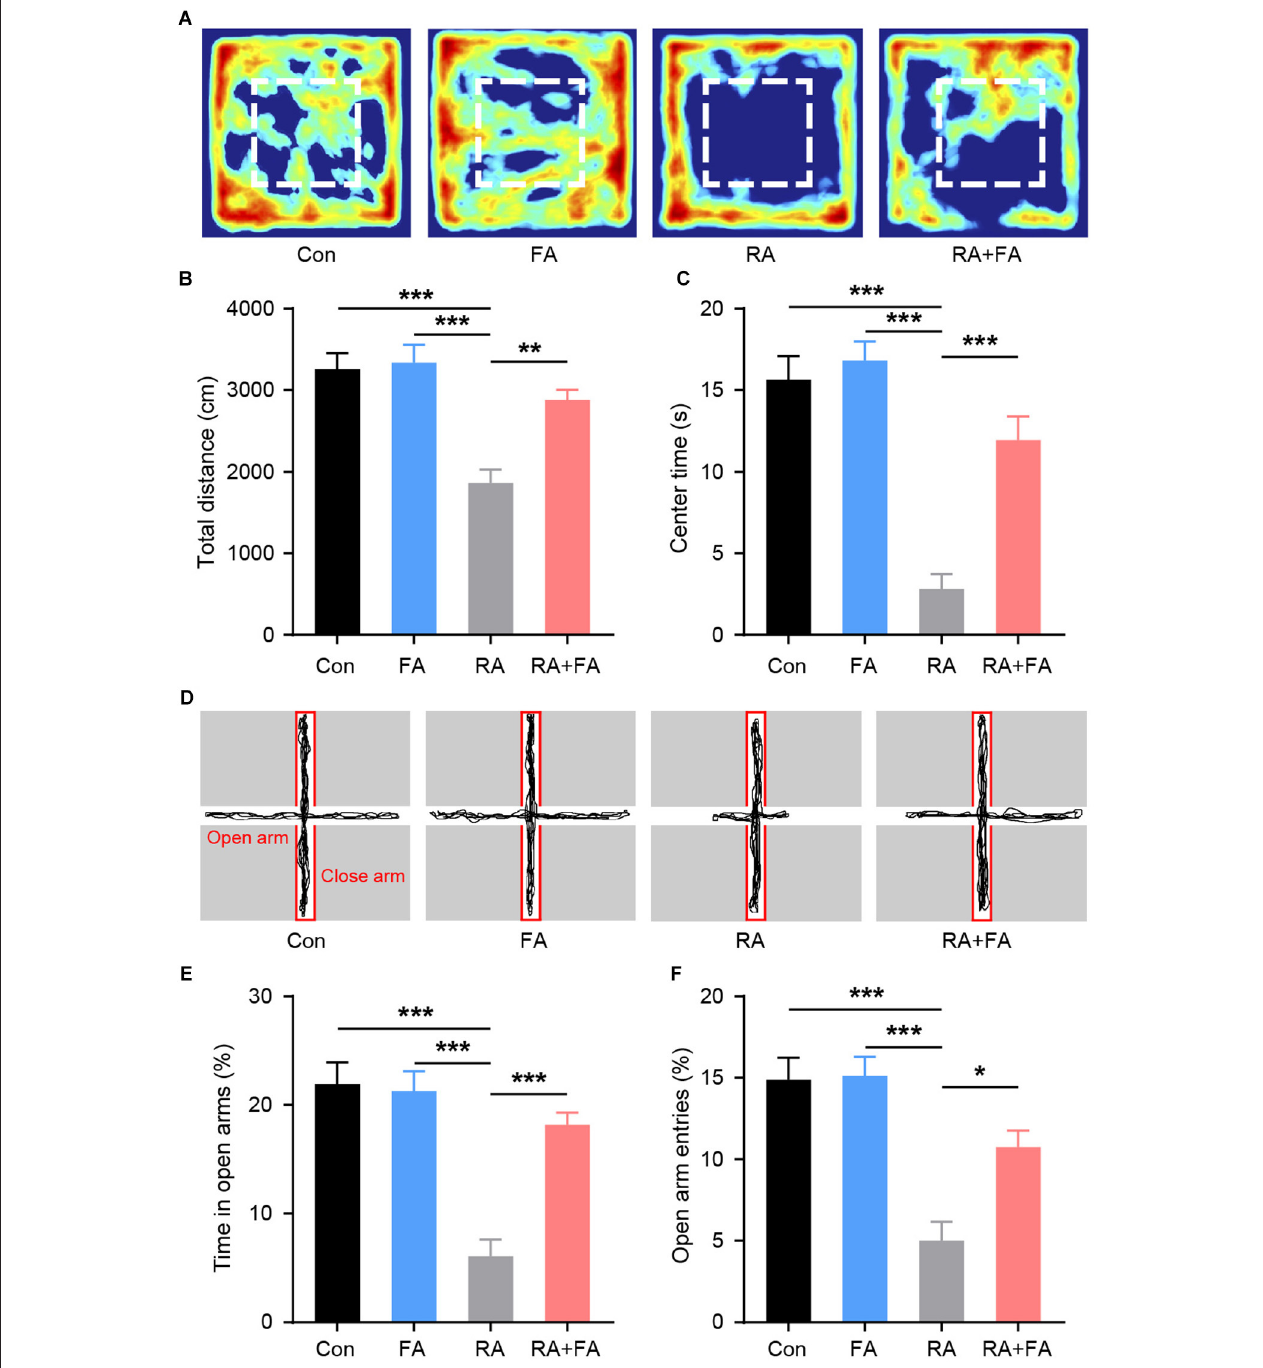
FIGURE 7 | Effect of folic acid (FA) pre-administration on emotional behaviors observed in female mice after ovarian radiation injury. (A) Heat map of the exploration trajectories representing the activity of mice in each group. Representative heat maps were selected from the mouse which was closest to the mean level for each group. Red boxes indicate center area. (B) Quantification of the total distance traveled for each group. (C) Quantification of center area exploration time for each group. (D) Representative track of elevated plus maze exploration for each group. (E) Time spent in the open arm of the elevated plus maze. (F) Entries into open arms of elevated plus maze. Error bars, standard error of mean (SEM). N = 8, * p < 0.05, ** p < 0.01, and *** p < 0.001.